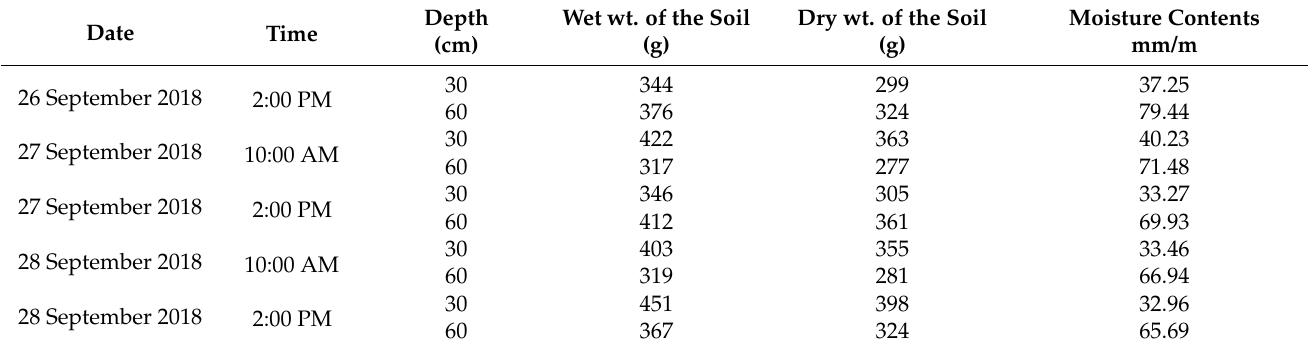
Table 3. Field capacity data of the experimental site.